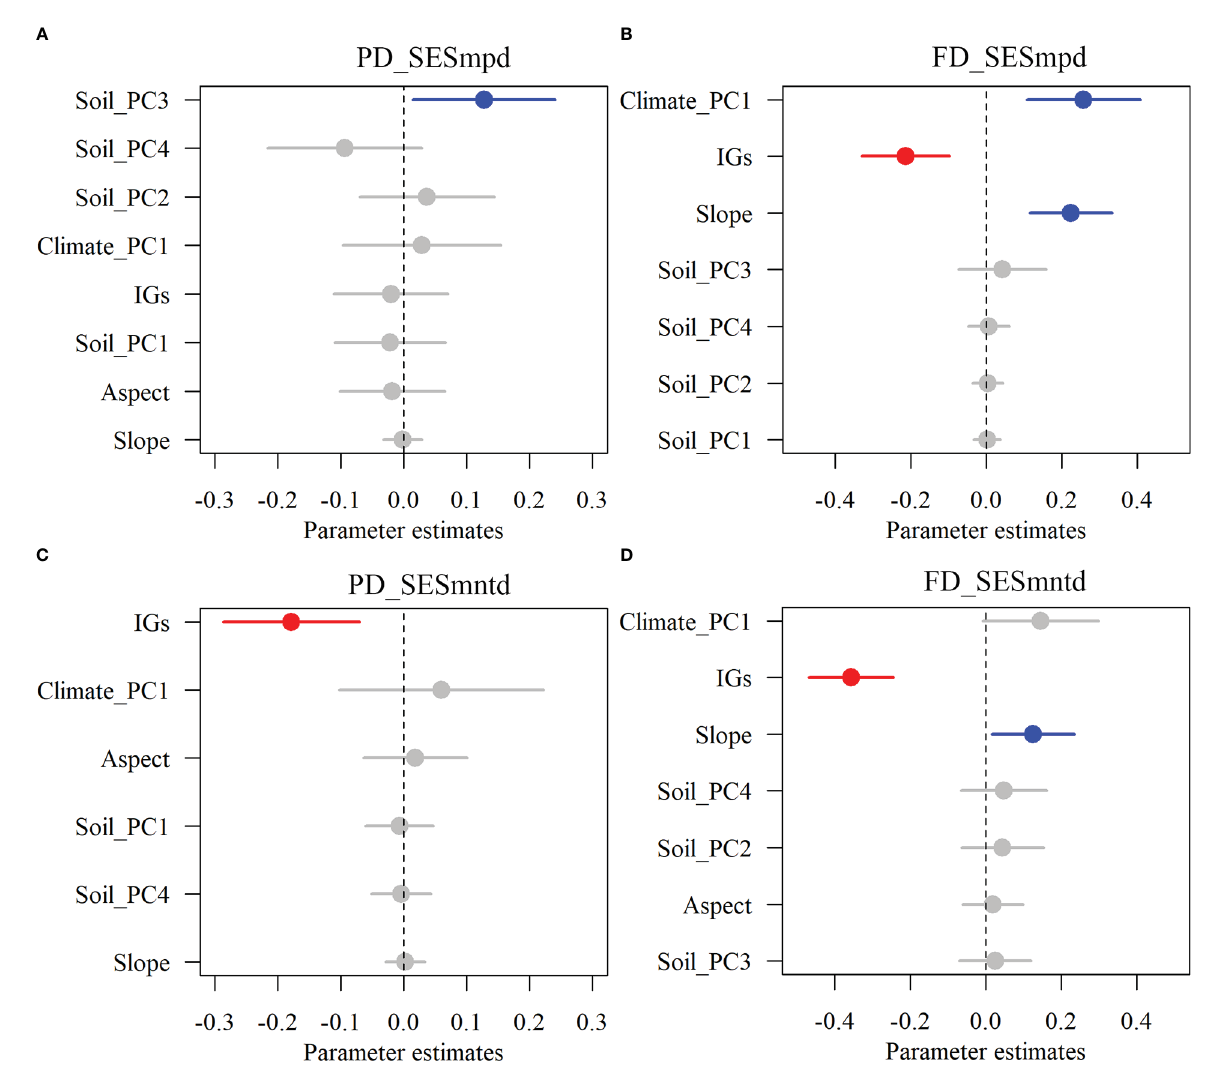
FIGURE 5 The effects of multi-dimensional variables on standardized phylogenetic (A, C) and functional (B, D) structures of plant communities. Dots with error bars denote the effect sizes and 95% CI, respectively. Blue and red colors represent signi fi cant positive and negative effects, respectively. Climate_PC1 (climate), Soil_PC1 (soil phosphorus), Soil_PC2 (soil nitrogen), Soil_PC3 (soil water content), Soil_PC4 (soil organic matter), Slope (slope), Aspect (aspect), and IGs (inundation